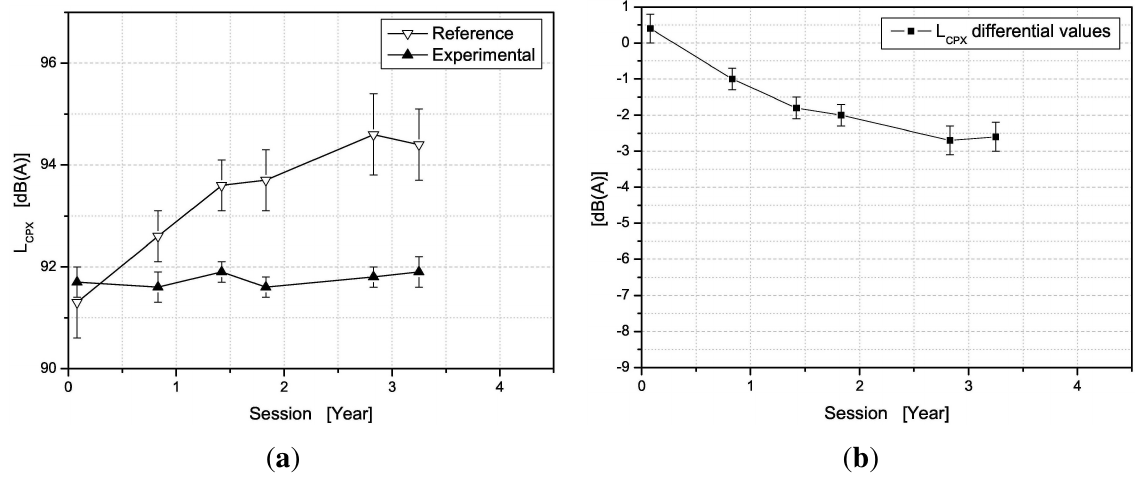
Figure 19. Absolute ( a ) and differential ( b ) values of L along measurement sessions CPX (e.g., time, in years) for Asphalt rubber (wet process) surface laid in Site 6. The CPX spatial distribution, shown in Figure 20, points out its homogeneity and its stability in time: since the first measurement session and till the last one, lanes show equivalent